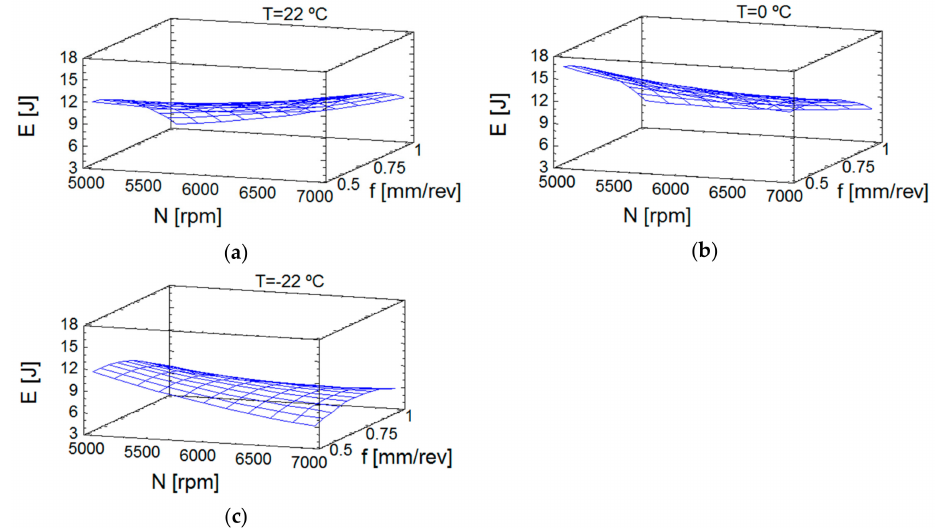
Figure 5. Estimation of response surface for energy: ( a ) Temperature of 22 ◦ C; ( b ) Temperature of 0 ◦ C; ( c ) Temperature of − 22 ◦